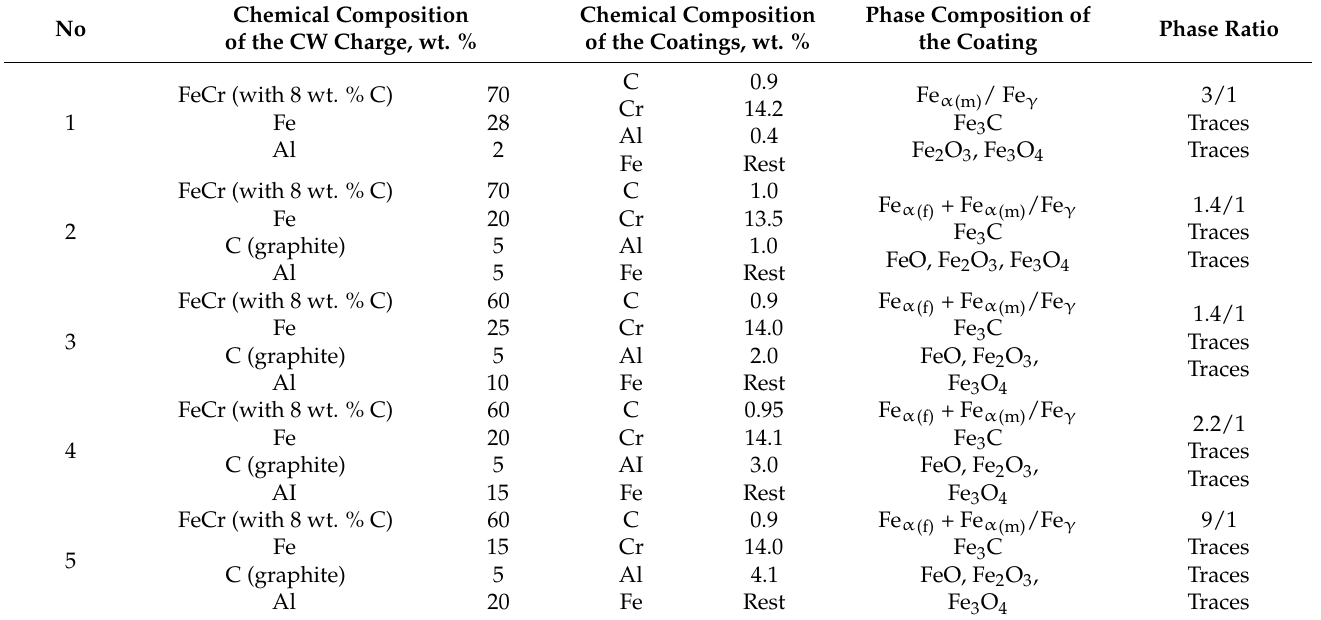
Table 3. Effect of the Al content in the CW charge of the Fe–Cr–C–Al system on the phase composition of sprayed coatings.